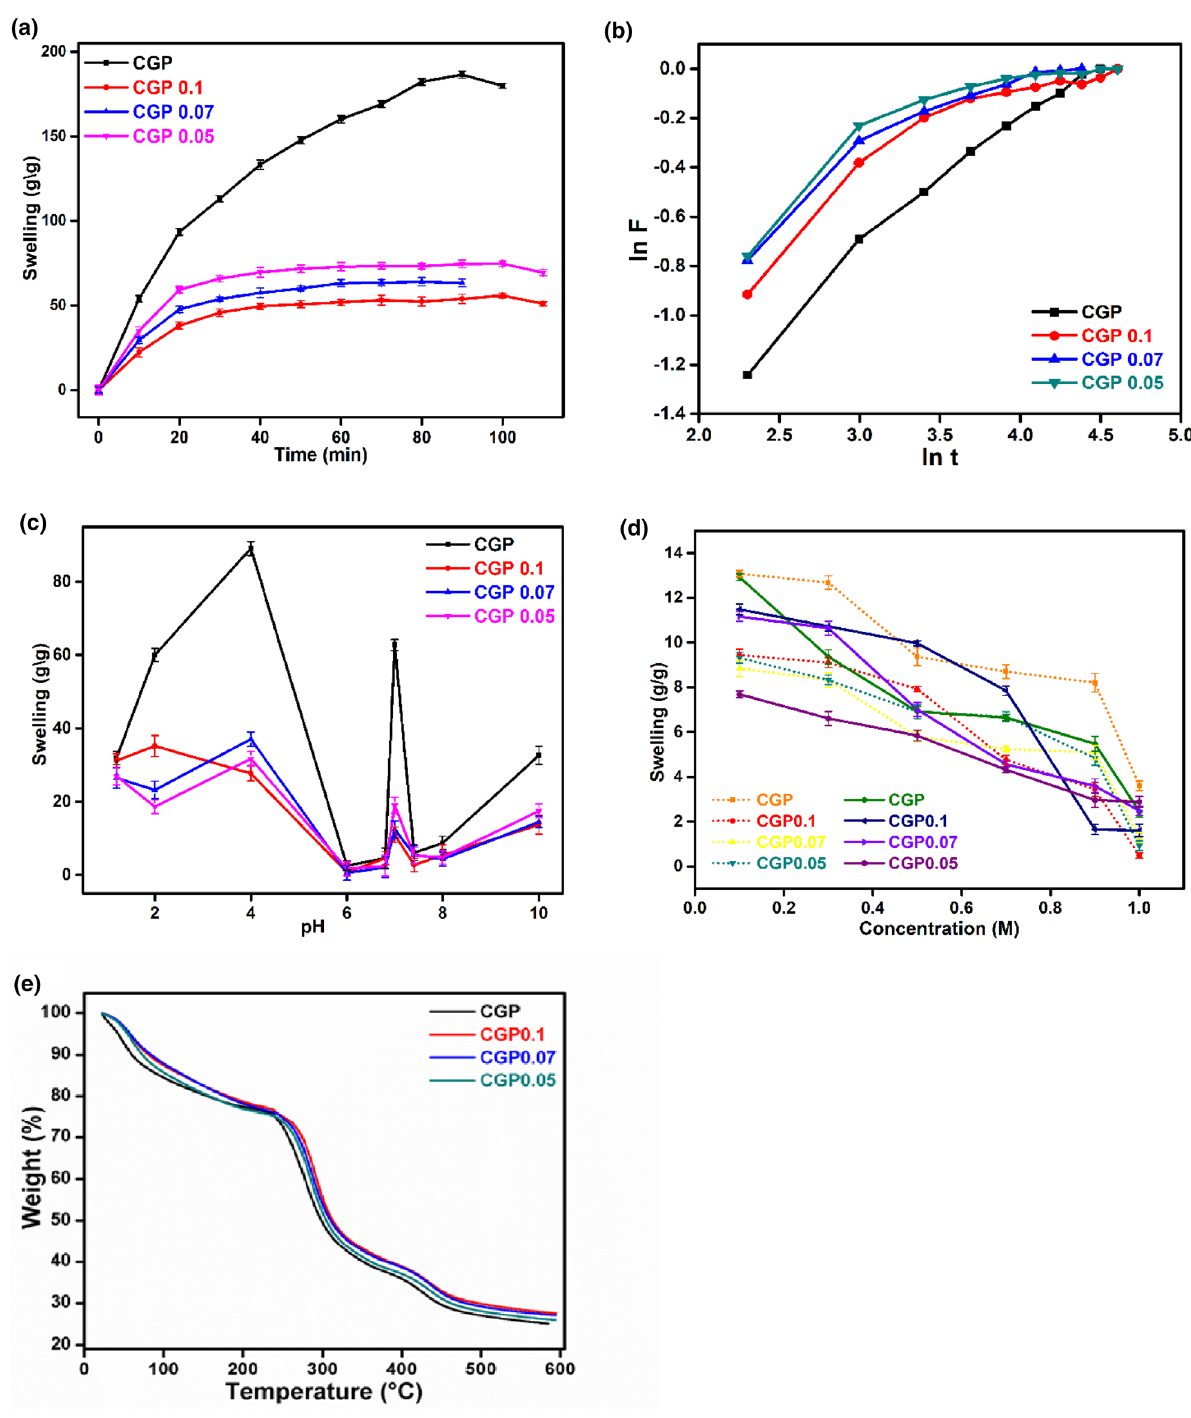
Figure 3. ( a ) Time dependent swelling behavior of CGP hydrogels in distilled water. ( b ) Kinetics of CGP hydrogel samples in distilled water ( c ) Swelling response of CGP hydrogels in different pH solutions ( d ) Swelling response of CGP hydrogels in different molar concentrations of NaCl (dotted) and CaCl 2 (solid) ( e ) TGA thermograms of CGP hydrogels. Data is presented as a mean ± SD (n =